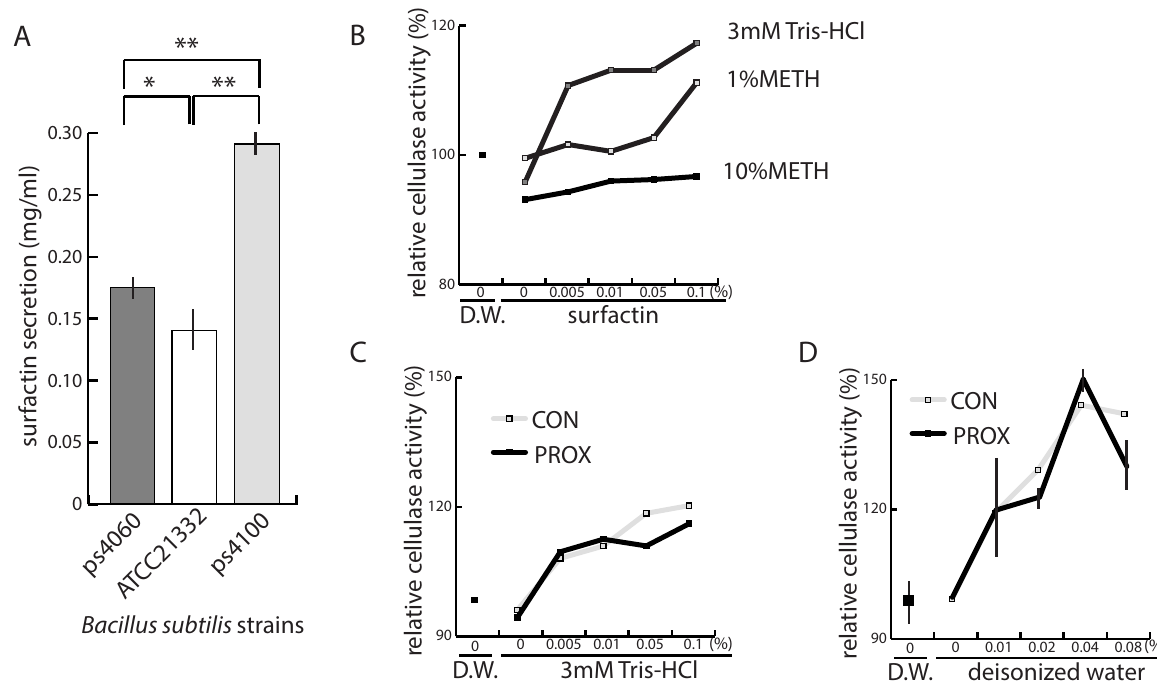
Fig 4. Surfactin production by two novel Bacillus subtilis strains compared to ATCC21322 and the effect of surfactin on cellulase activity. A. Comparison of surfactin secreted in a 50-mL medium in triplicates at 30˚C. B. Effect of surfactin on cellulase activity in the presence of 3 mM Tris-HCl (pH 8.0), 1% methanol, 10% methanol. C and D. Effects of two sources of surfactin, Sigma-Aldrich (CON) and Proxenrem (PROX), on cellulase activity in the presence of 3mM Tris-HCl and deionized water. Control surfactin was purchased from Sigma-Aldrich, St. Louis, MO, USA. The x-axes in B, C, and D, show surfactin concentrations. Bars show standard deviations. Single ( � ) and double ( �� ) asterisks respectively indicate p -values less than 0.05 and 0.001 by